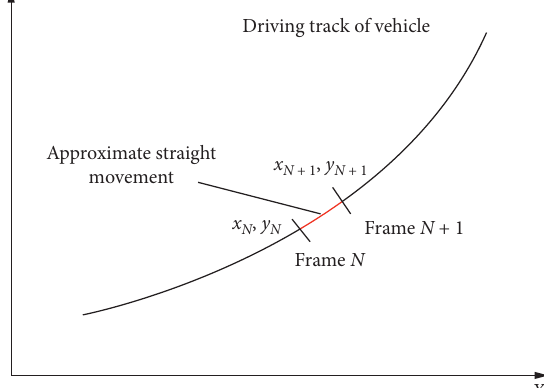
Figure 1: Approximate linear motion of the vehicle between ad- jacent image